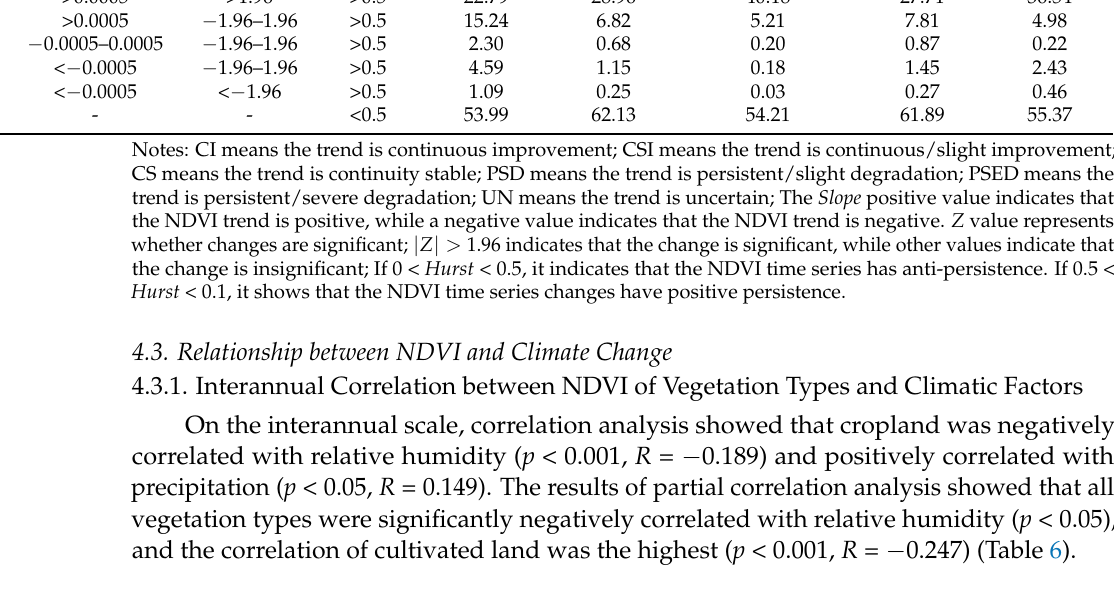
Table 6. Correlation coefficient between different vegetation types NDVI and climatic